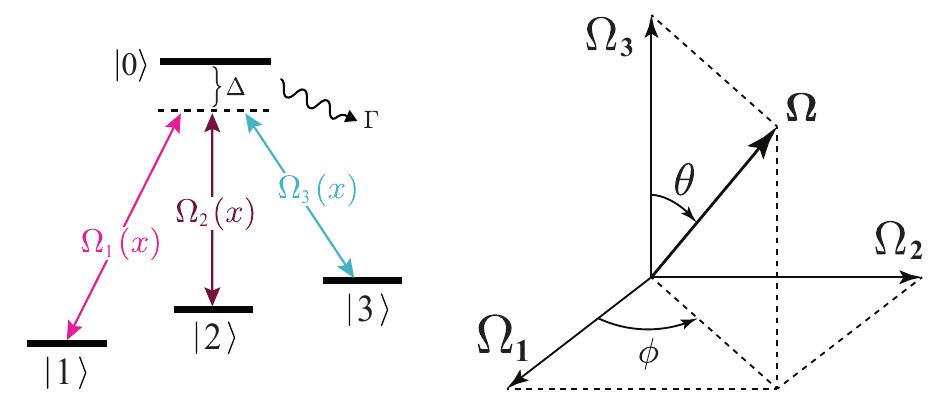
Figure 1: Tripod atom light coupling scheme.